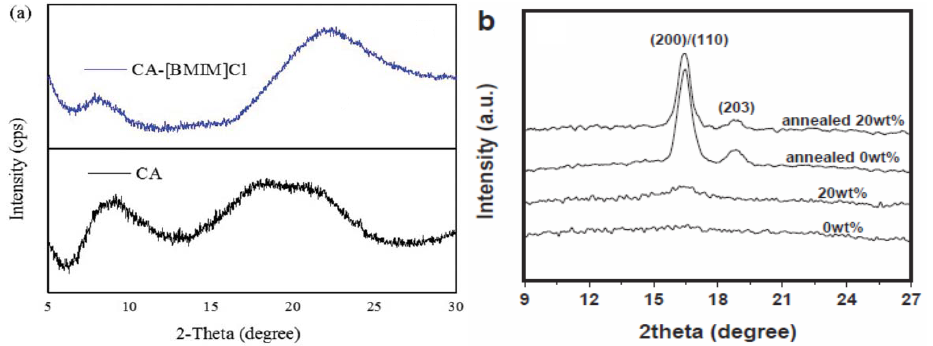
Figure 8. XRD patterns of ( a ) electrospun cellulose acetate fibers ( top ) [25]; and ( b ) electrospun PLA fibers ( top ) [39] assisted by different ionic liquids as additives.